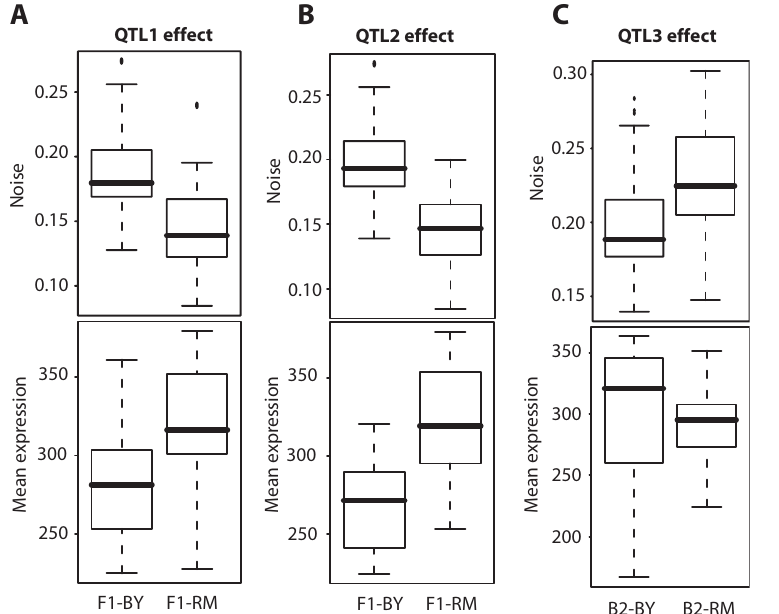
Figure 3. Contributions of QTL to P MET17 -GFP noise (top panels) and mean expression (bottom panels). A–B) S288c 6 RM11-1a segregants were separated in two groups (F1-BY and F1-RM) according to their genotype at QTL 1 (A) or QTL 2 (B). For both QTL, the inheritance of the RM11-1a allele was associated to lower noise and higher mean expression. The differences in mean expression between the F1-RM and F1-BY groups were highly significant: P =4 6 10 2 6 (A) and P =7.8 6 10 2 9 (B). C) Strain GY157 was crossed with a derivative of S288c, and fifty five segregants were characterized. These segregants were separated in two groups (B2-BY and B2-RM) according to their genotype at the candidate region on chromosome V. The RM11-1a allele conferred a significant increase in noise ( P =3.5 6 10 2 3 ), therefore validating the region as a third QTL (QTL 3 ), while no effect of the genotype was observed on mean expression.